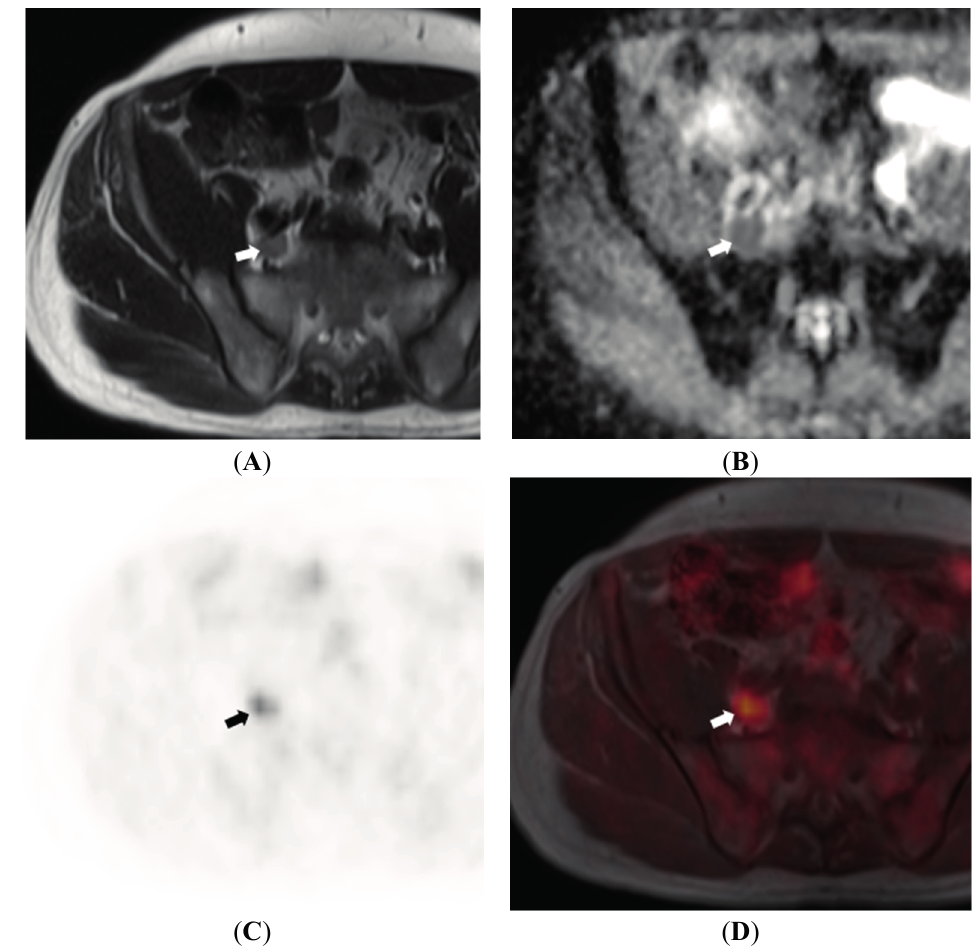
Figure 5. 64 year old male patient with prostate cancer. T2WI ( A ) show a large right common iliac lymph node (arrow) which exhibits restricted diffusion on ADC map ( B ); 18 F-choline PET ( C ) and fusion PET/MRI ( D ) confirm the lymph node to be metabolically active, further increasing confidence regarding it being